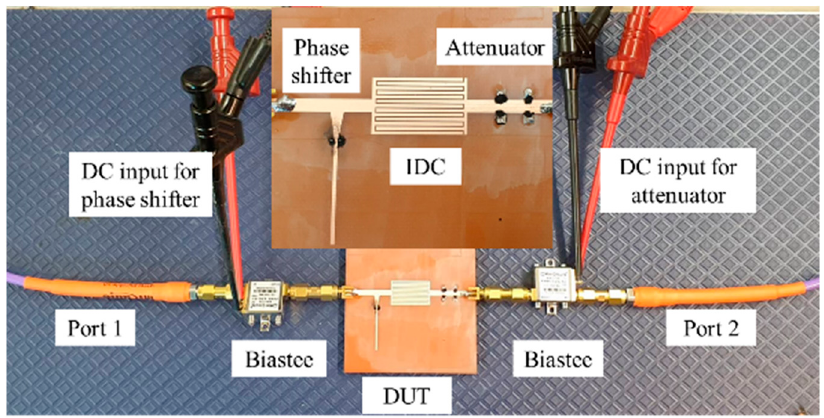
Figure 8. Measurements Setup with device under test in the inset.